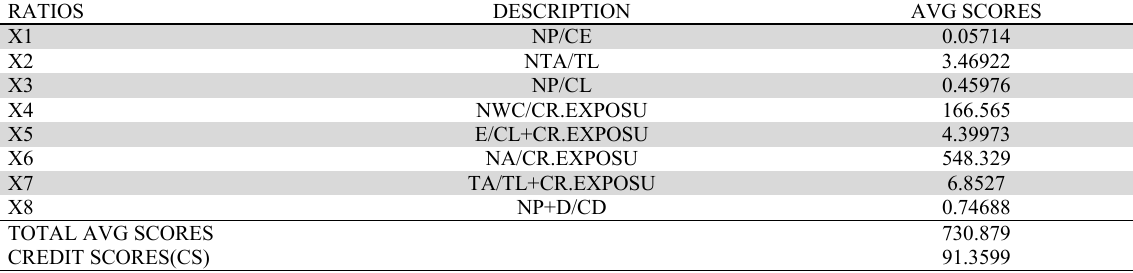
Risk Description Model- Ratio Measurement(Raymond)